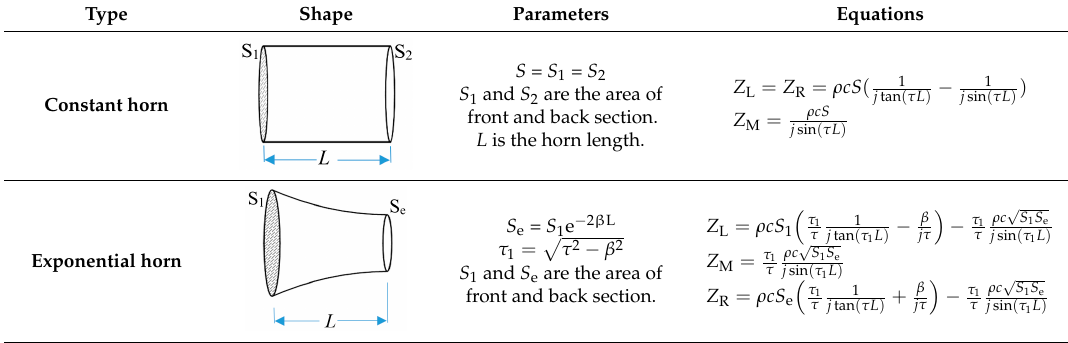
Table 1. Impedance of the horn structure in the analytical model. S 1 and S 2 are the area of front and back section. L is the horn length.